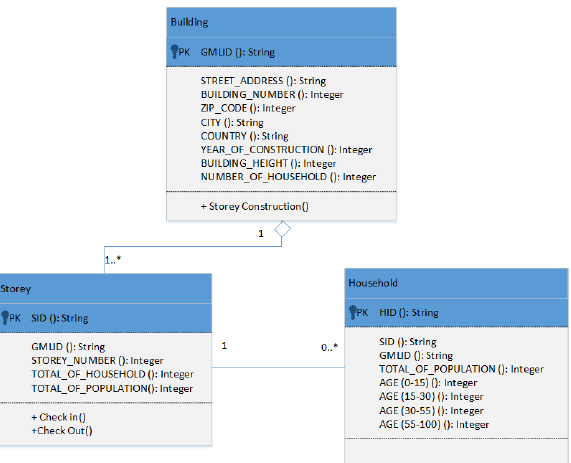
Figure 2. The UML of hierarchy